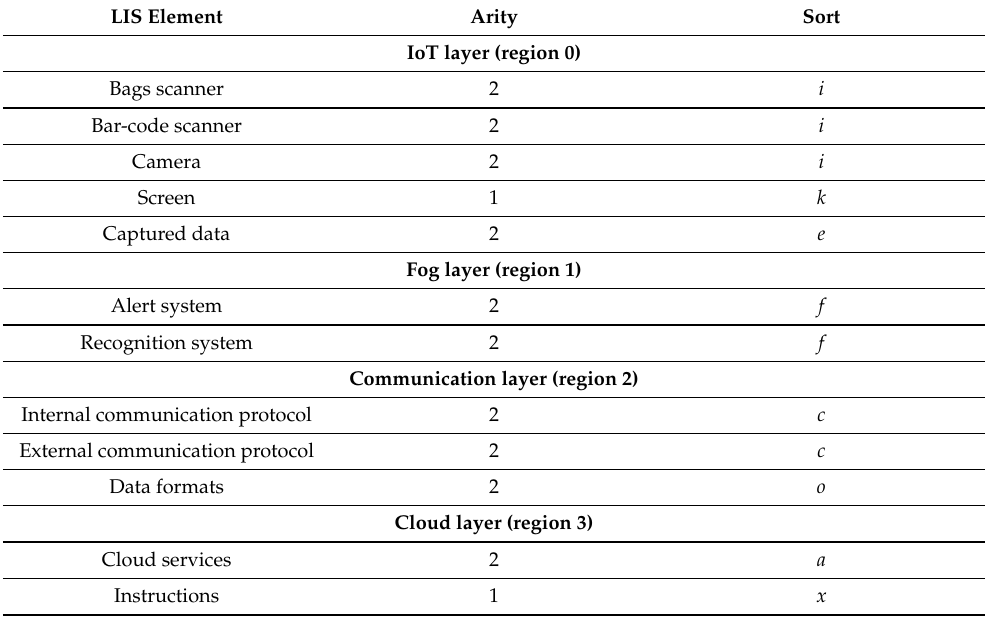
Table 3. Sorting discipline associated to B F .